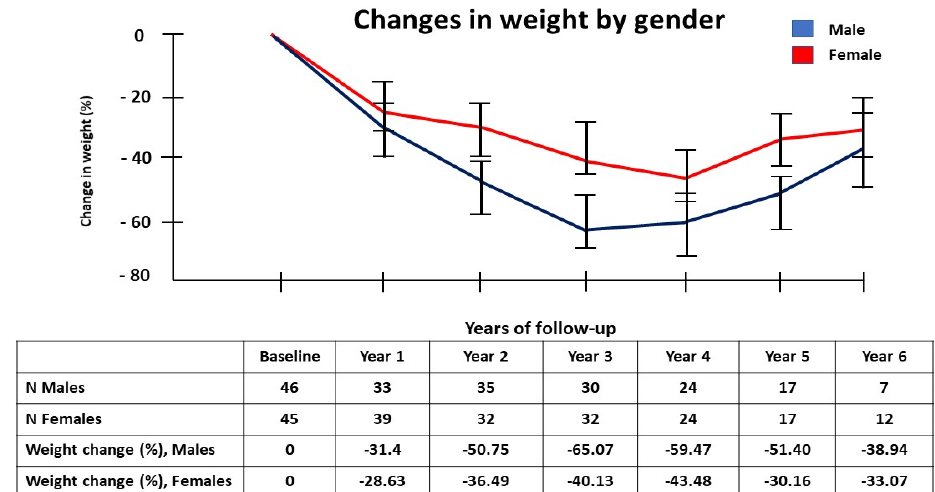
Figure 1. Graphical representations of changes in weight (%), with the error bars representing the ± 2 SD during the 6-year follow-up period for all patients who underwent bariatric surgery (blue line), for those who underwent SG (red line), and those who underwent RYGB (green line).